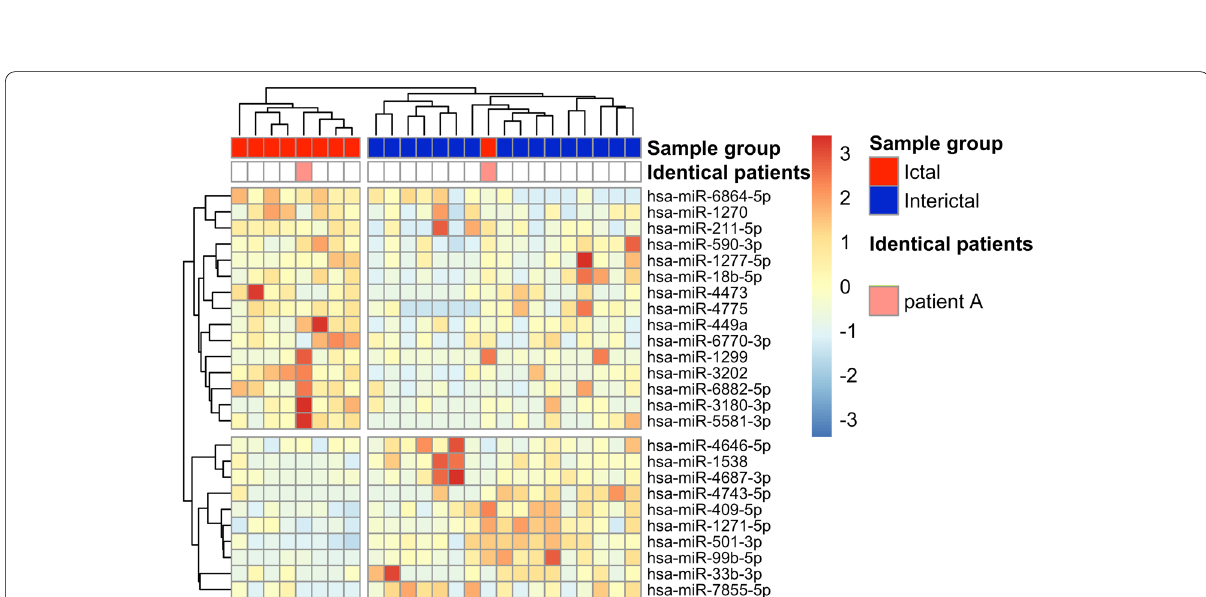
Fig. 2 Heat map representation of differentially expressed genes in the ictal vs interictal comparison. Columns represent samples, and rows represent genes. Pearson correlation was respectively calculated between samples and genes, visualised by dendrograms. Samples from patient “A” in different ictal and interictal periods are marked with respective